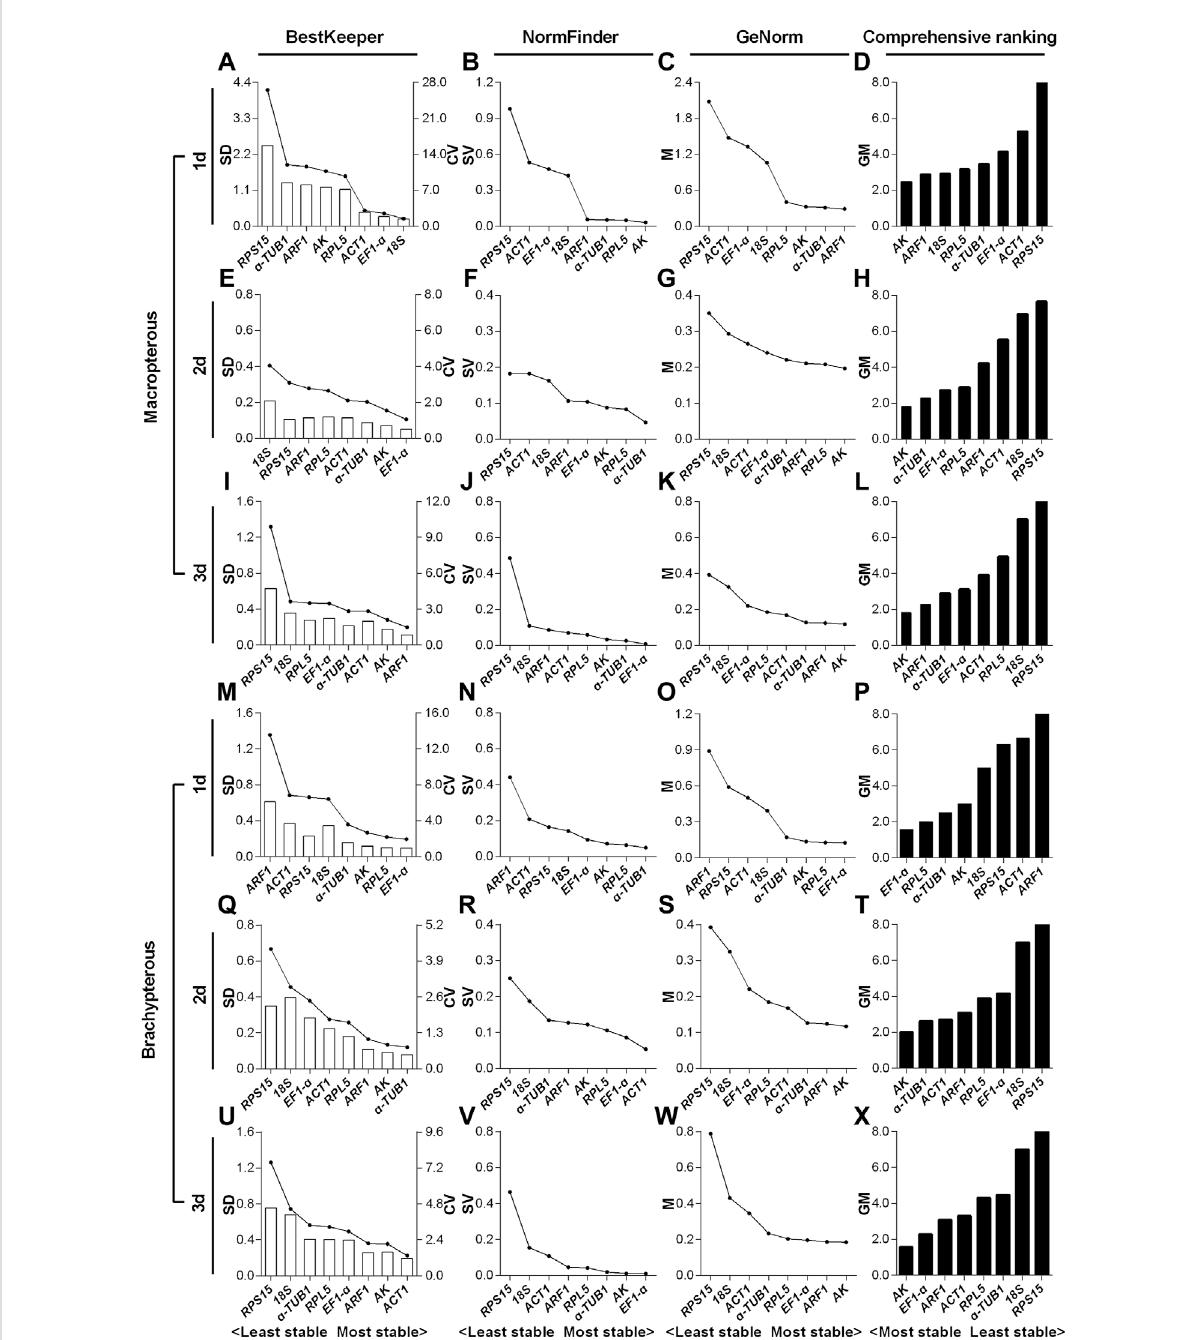
FIGURE 4 Expression stability evaluation of candidate reference genes respectively for 1- to 3-day-old macropterous and brachypterous female adults of N.lugens byBestKeeper,NormFinder,GeNormandcomprehensiveanalyses.Eachrowofthepanelindicatesthattheexperimentalsamplesarefrom 1-day-old (1d), 2-day-old (2d)and 3-day-old(3d)macropterous [1d, (A – D) ;2d, (E – H) ;3d, (I – L) ]and brachypterous [1d, (M – P) ;2d, (Q – T) ; 3d, (U – X) ] female adults under the hypomagnetic fi eld versus local geomagnetic fi eld. The standard deviation (SD) and coef fi cient of variation (CV) were given by BestKeeper (A,E,I,M,Q,U) . The stability value (SV) was given by NormFinder (B,F,J,N,R,V) . The average expression stability (M) was given by GeNorm (C,G,K,O,S,W) . The comprehensive ranking was further generated based on the results derived from the geometric mean (GM) of these three algorithms (D,H,L,P,T,X) . Stable reference genes generally have lower SD, SV, M and GM